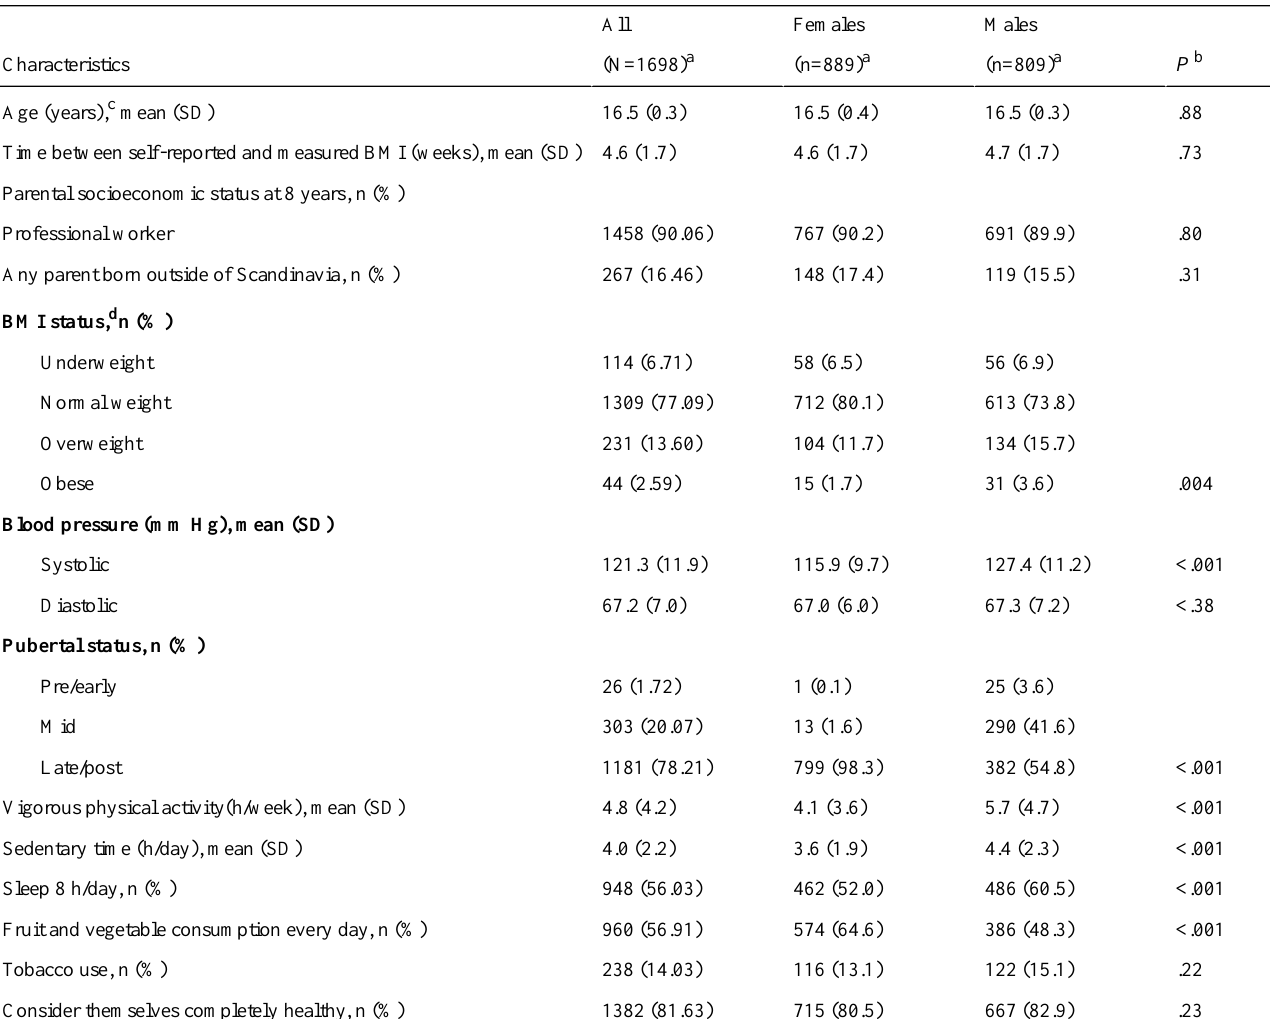
Table 1. Description of the study population (N=1698) derived from a prospective birth cohort born in Stockholm in